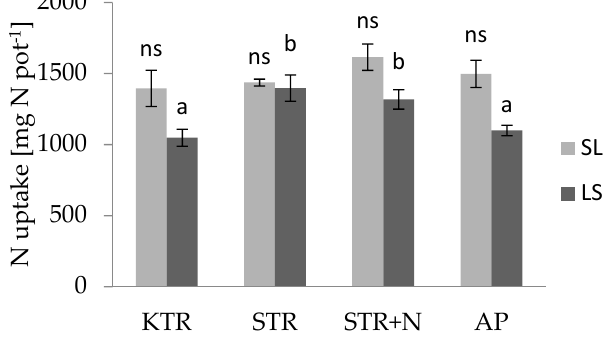
Figure 2. Uptake of N (sum for four harvests) by grass. The standard deviation within each treatment (n = 3) is indicated by the line extending from the column. Different letters (a, b) indicate significant differences ( p < 0.05); ns: not significant.